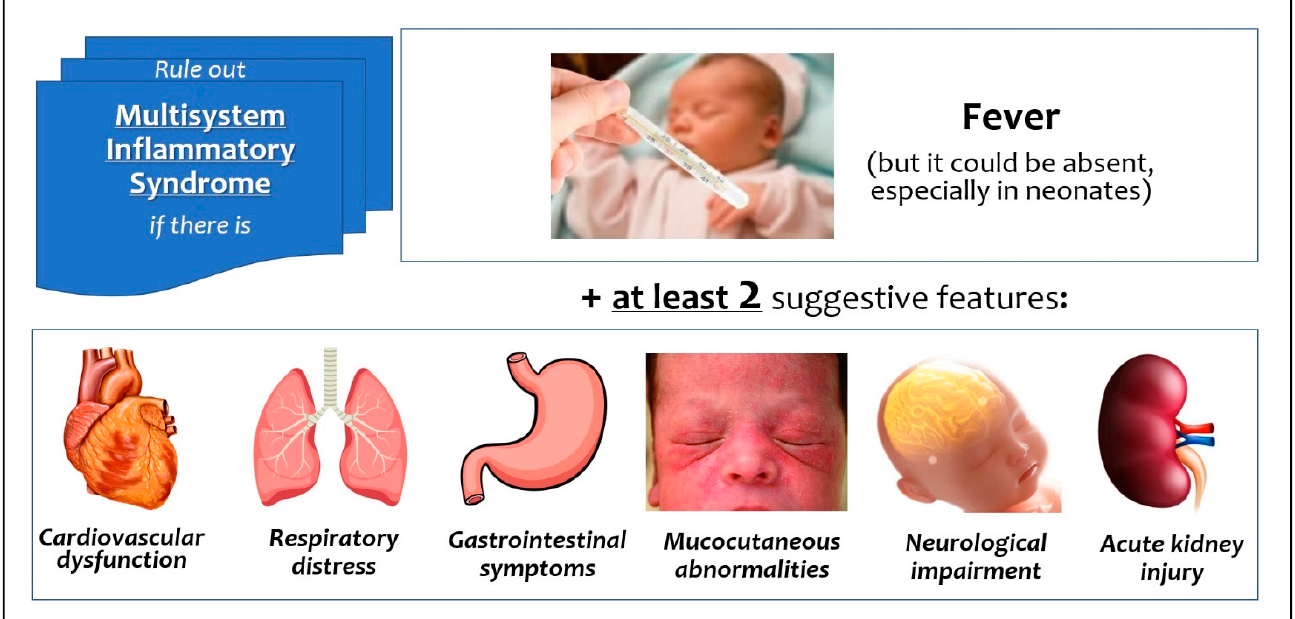
Figure 1. Signs and symptoms of multisystem inflammatory syndrome related to SARS-CoV-2 in neonates and infants.